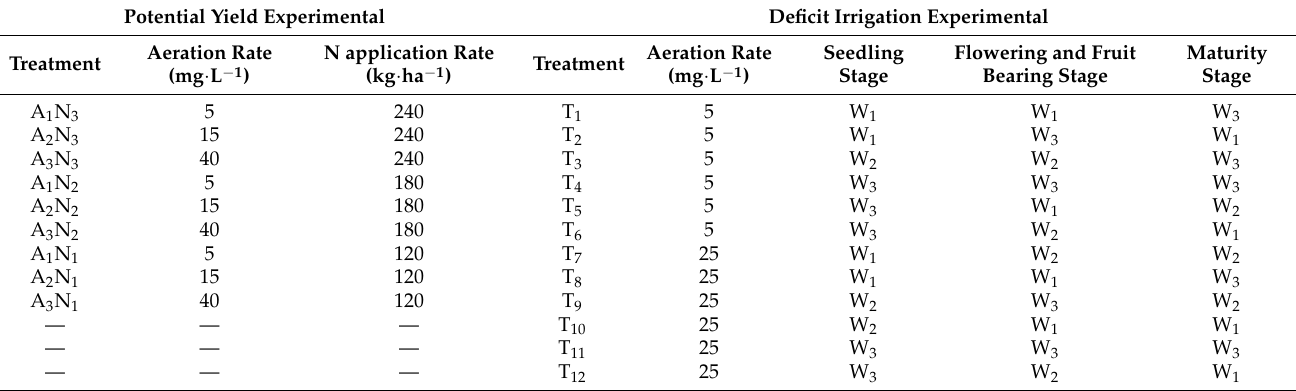
Table 2. Experimental